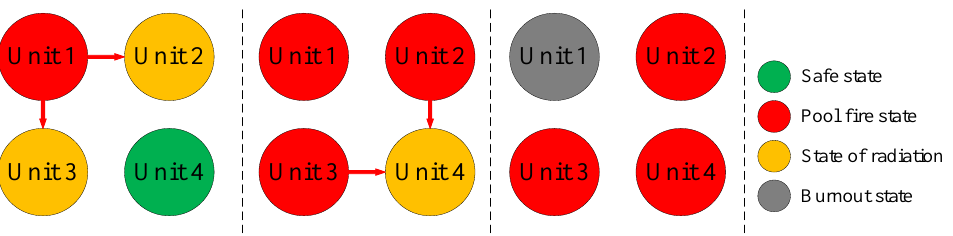
Figure 1. Spatio-temporal evolution of fire domino